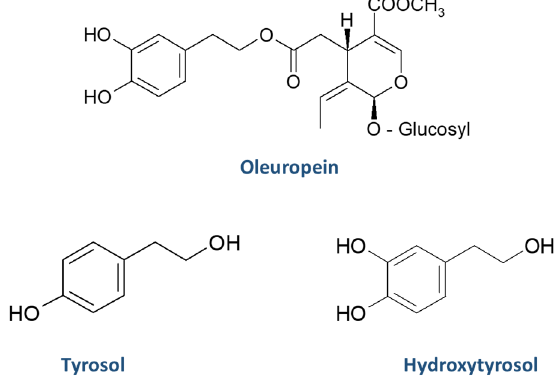
Figure 2. Chemical structures of oleuropein, tyrosol, and hydroxytyrosol.